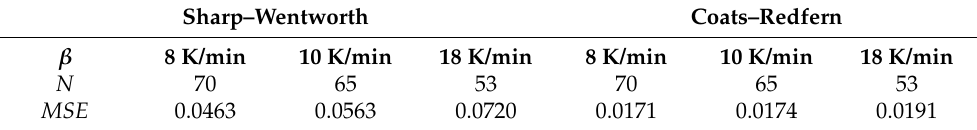
Table 5. The mean square errors of the reaction of Fe 2 O 3 → Fe 3 O 4 for the explicit Euler method.